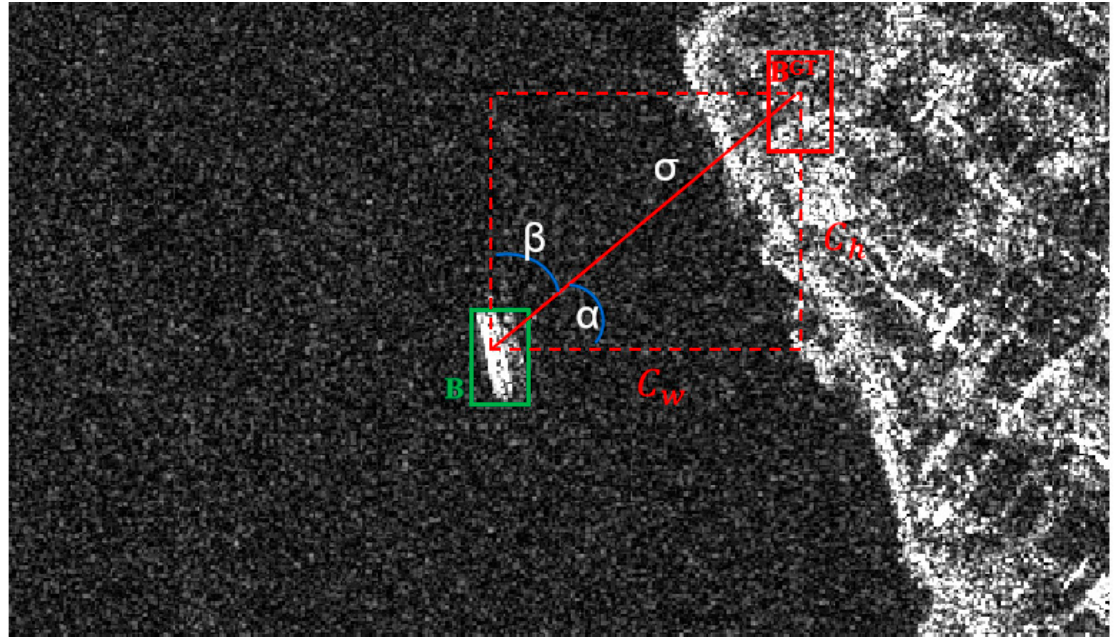
Figure 6. Schematic diagram of angle cost.